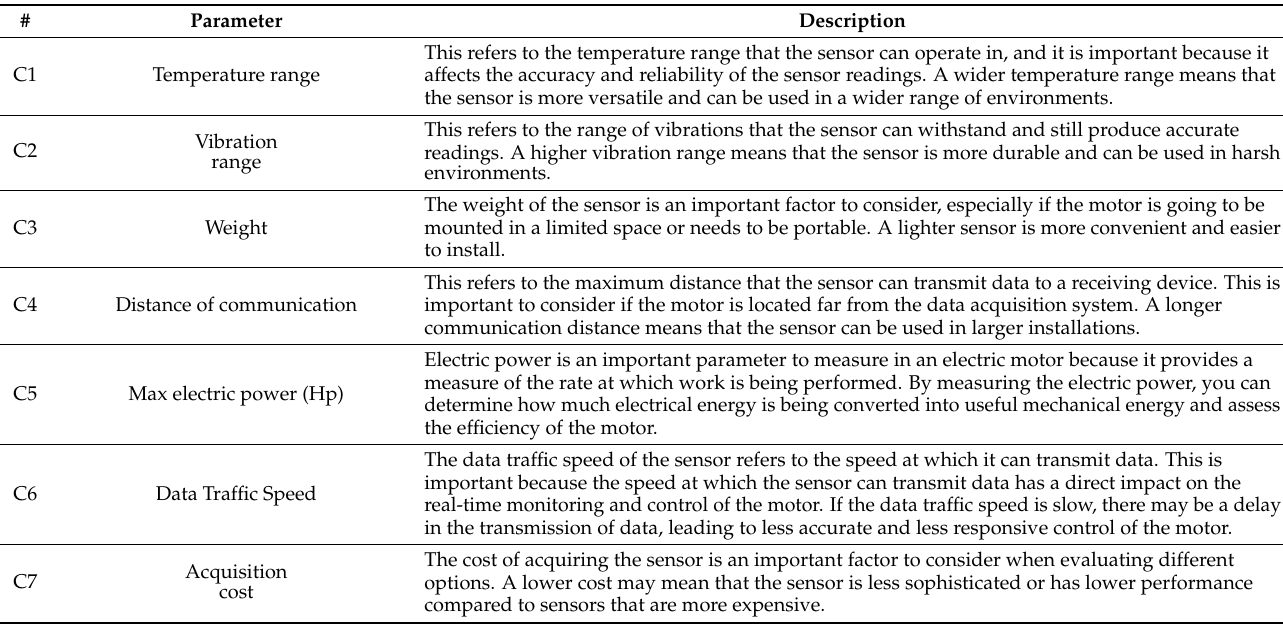
Table 4. Parameters decision of smart sensors.